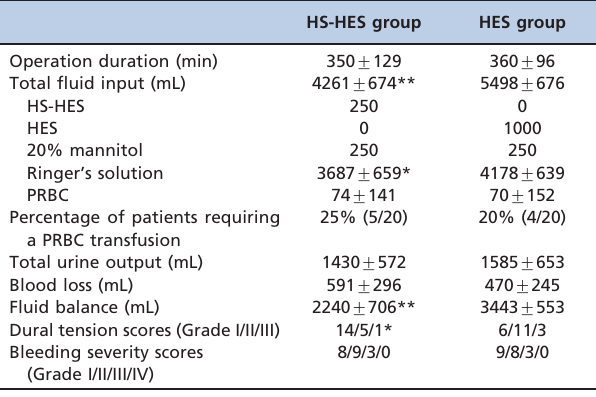
Table 2 - Clinical parameters of the patients treated with HS-HES (n= 20) or HES (n=